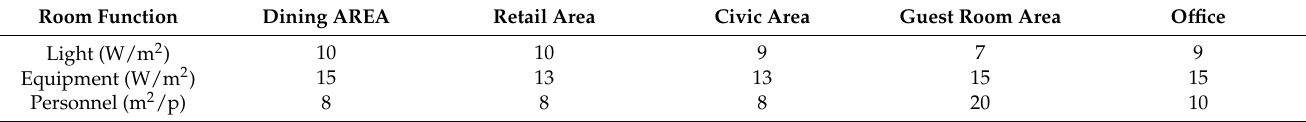
Table 3. Power density of personnel, lighting and equipment in main functional rooms.